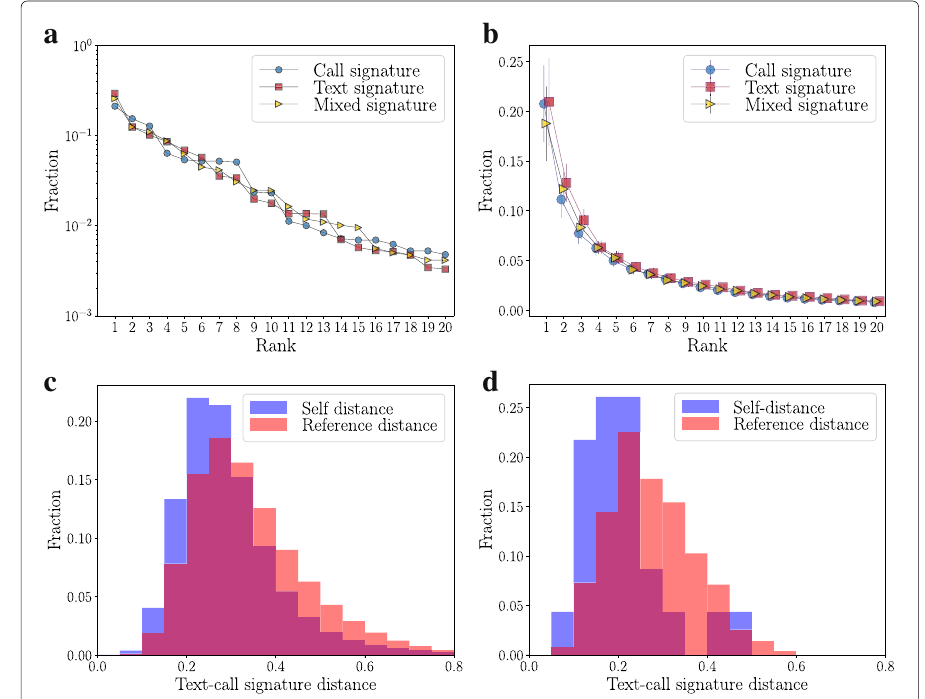
Fig. 3 The Similarities of Social Signatures of Different Types. Panel a shows the call, text and mixed signatures of one person in the Dataset 1. The three signatures look similar. Panel b illustrates the average signatures over the population in Dataset 2. The population-level signatures are also fairly similar. Panels c and d compare the distance distributions of the call and text signatures of same egos with the distributions of call and text signatures of different people as a reference. The call and text signatures of each ego are more similar than pairs of signatures of different